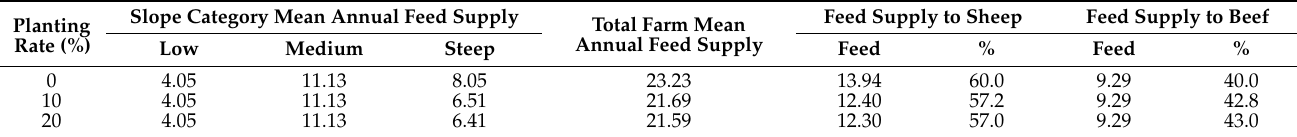
Table 4. Total mean farm annual feed supply in metabolizable energy (million megajoules) for the modelled farm based on low, medium, and steep slope types with shrubs planted on 10% of the farm at three planting rates (0%, 10%, and 20%) per year, and corresponding mean annual feed allocation to sheep and beef cattle.